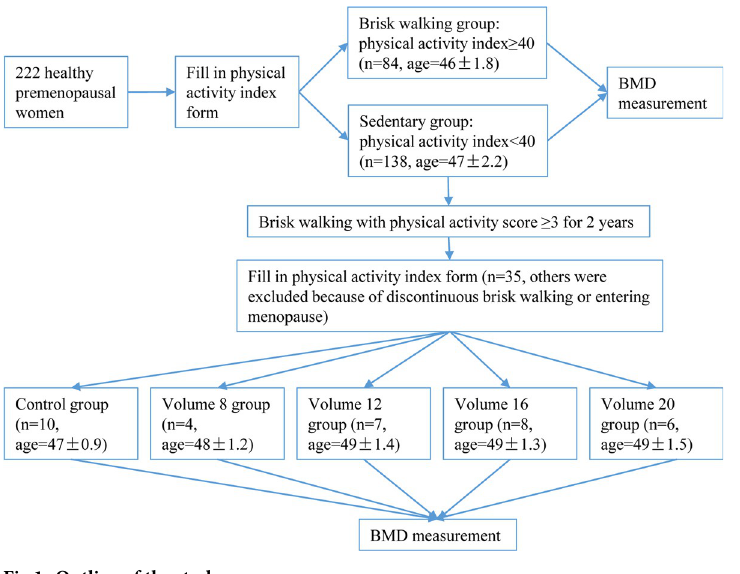
Fig 1. Outline of the